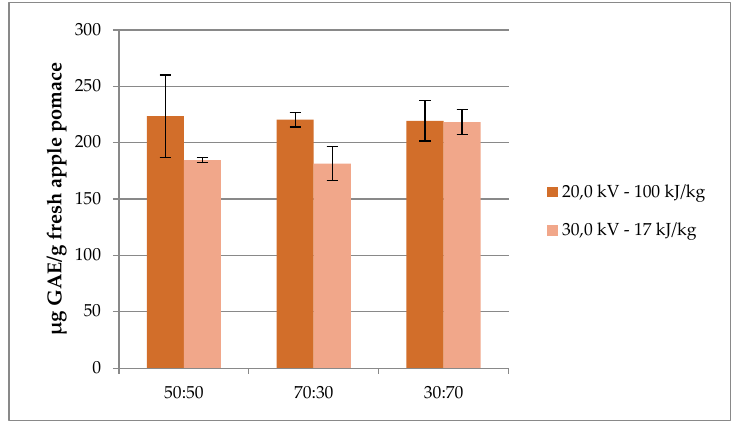
Figure 3. TPC results of PEF pre-treated extracts. Error bars represent the SD.